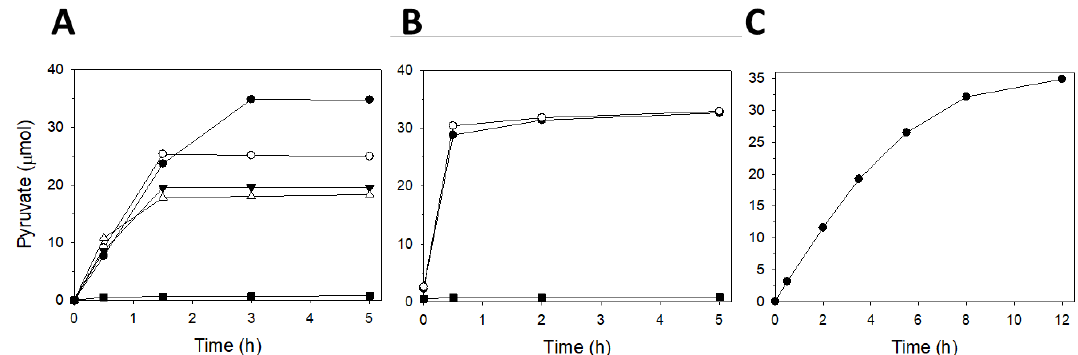
Figure 8. Optimization of the KG/PEP ratio in different KG phosphorylation reactions with ATP regeneration. ( A ) Reactions were performed in 1 mL of Tris-HCl buffer 50 mM and 50 μ mol of the